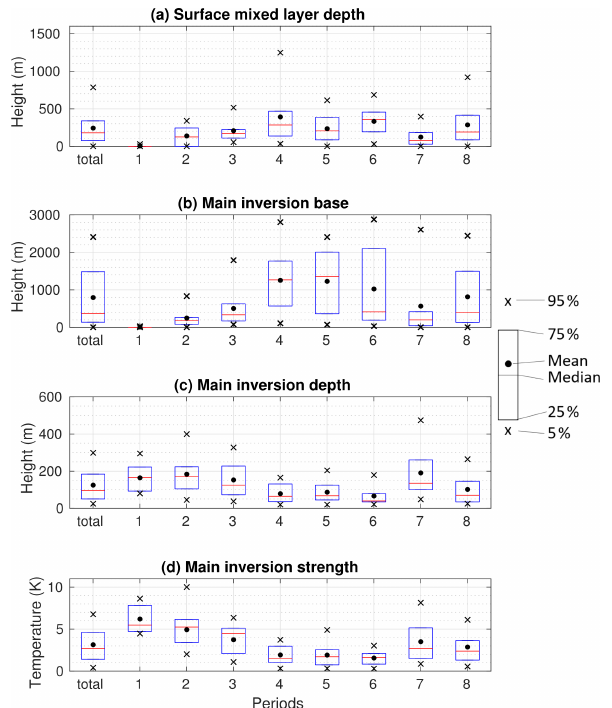
Figure 14. Statistics on surface mixed layer depth, main inversion base height, main inversion depth, and strength for the whole cam- paign and for the eight key